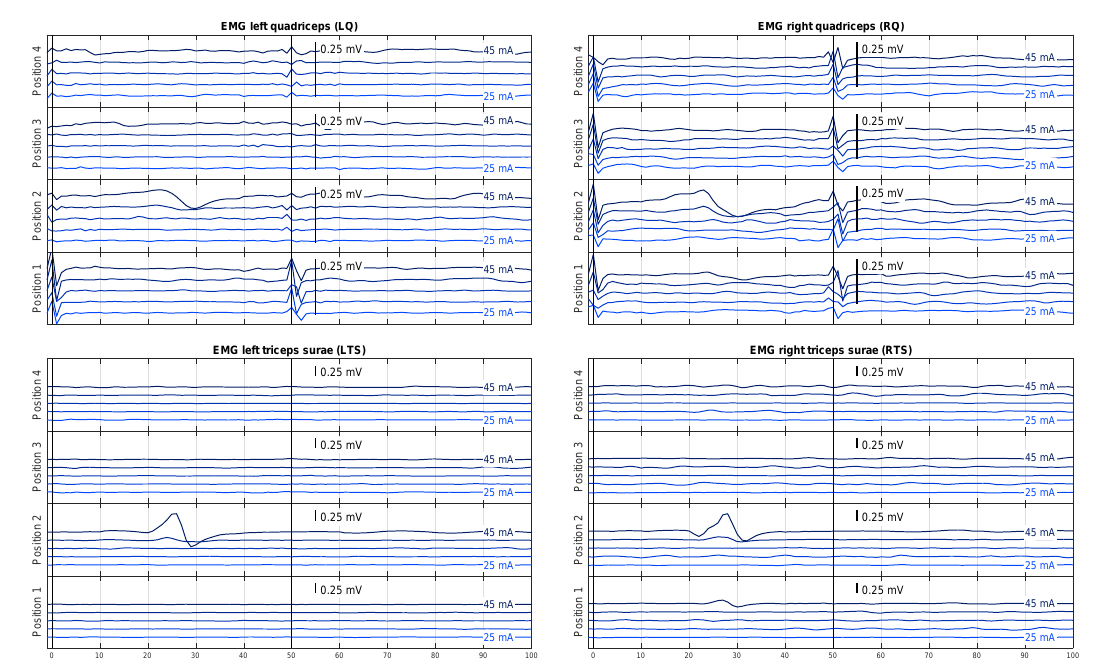
Figure A2. EMG recordings derived from bilateral quadriceps and triceps surae muscle groups during tSCS applied from different rostrocaudal electrode positions with double-stimuli of incremental amplitudes. Exemplary results derived from an individual with PD, P1. Each trace averaged from up to three double stimuli per stimulation amplitude; blue-shaded values are stimulation amplitudes.